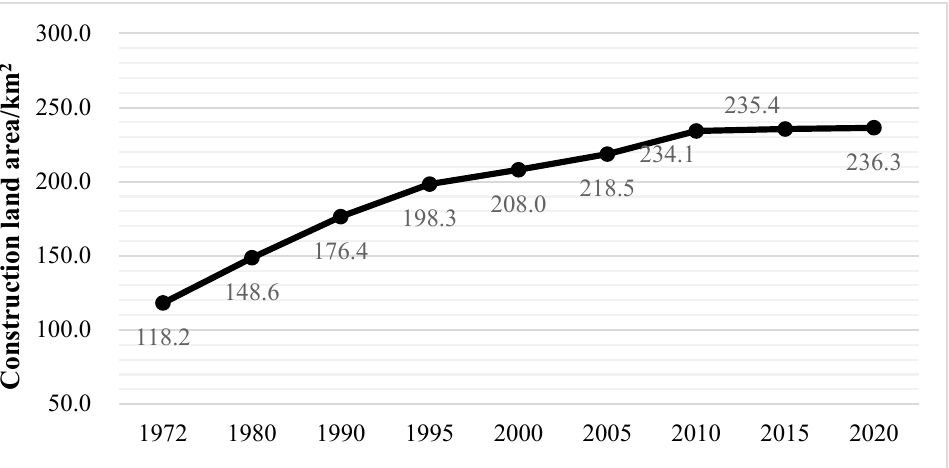
Figure 2. Line chart of changes in the area of construction land in Hong Kong.